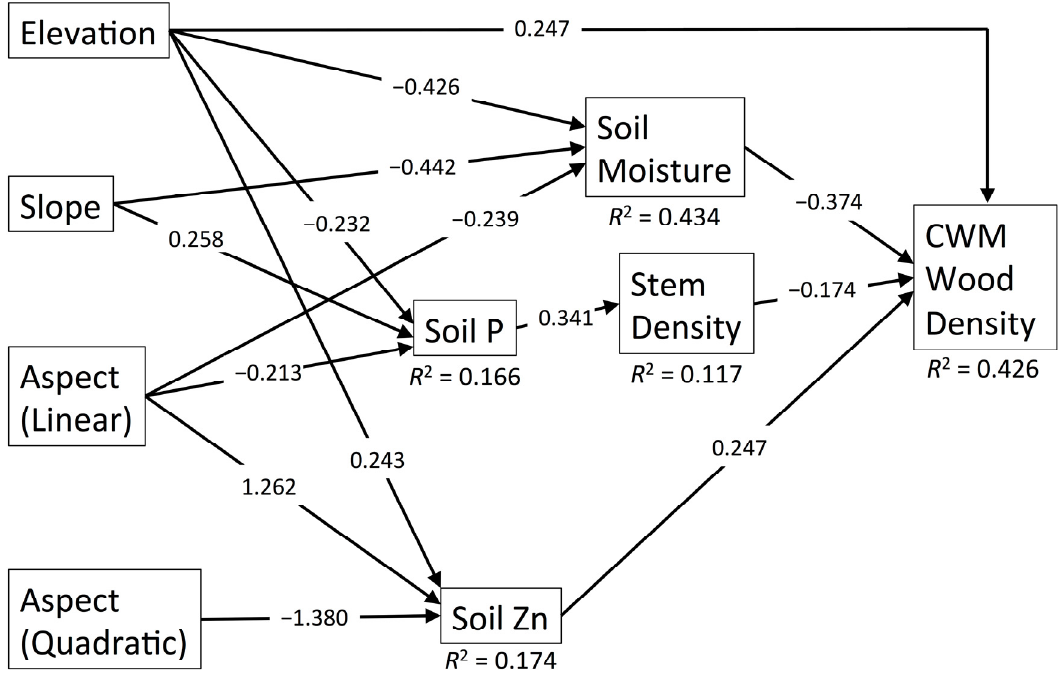
Figure 3. Path diagram for community-weighted mean wood density. Standardized path coefficients are given. R 2 values are total explained variance.